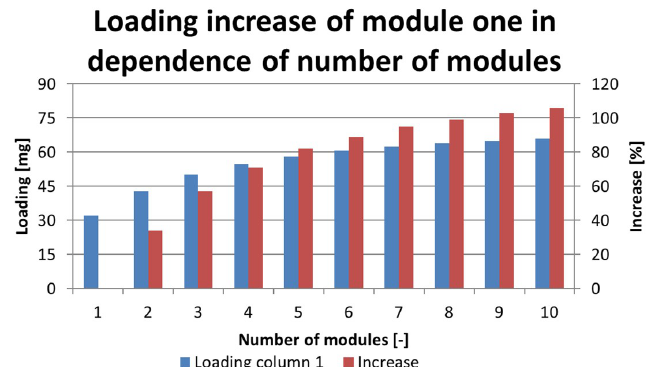
Figure 11. Increase in total loading of the first adsorber module depending on the number of modules used in the sequential loading step. The blue columns indicate the protein loading of the first column, the red columns represent the loading increase compared to only one module.